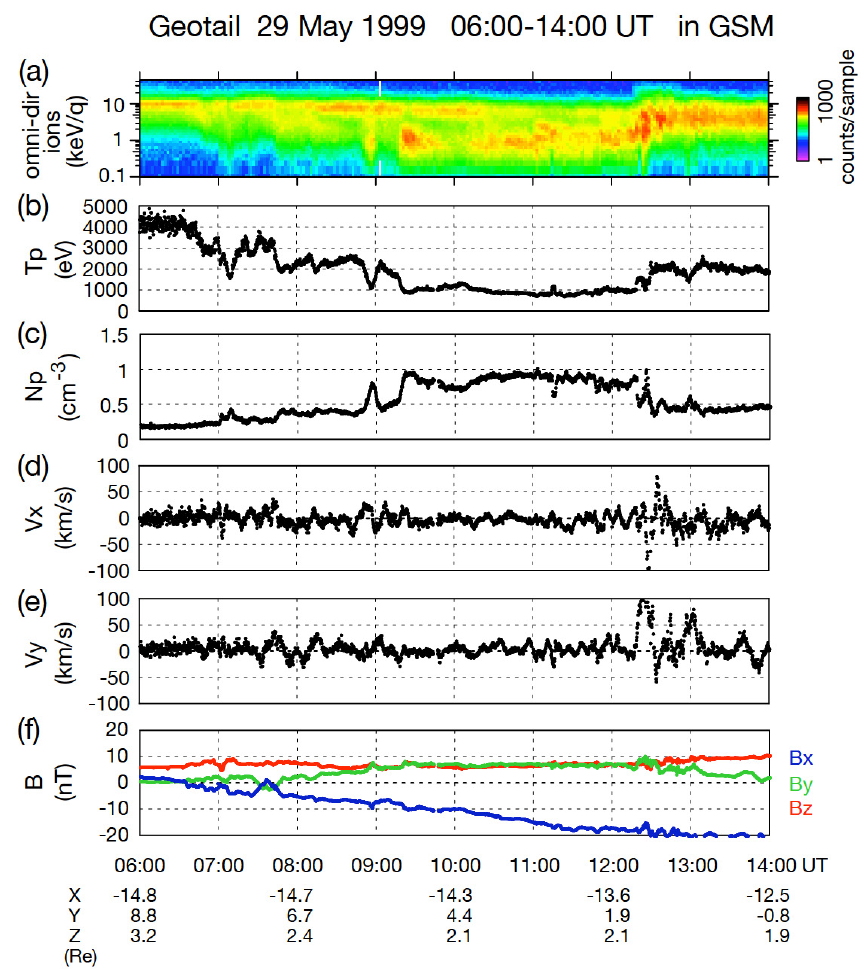
Fig. 4. Geotail observation between 06:00–14:00UT on 29 May 1999, in the same format as Fig. 1.